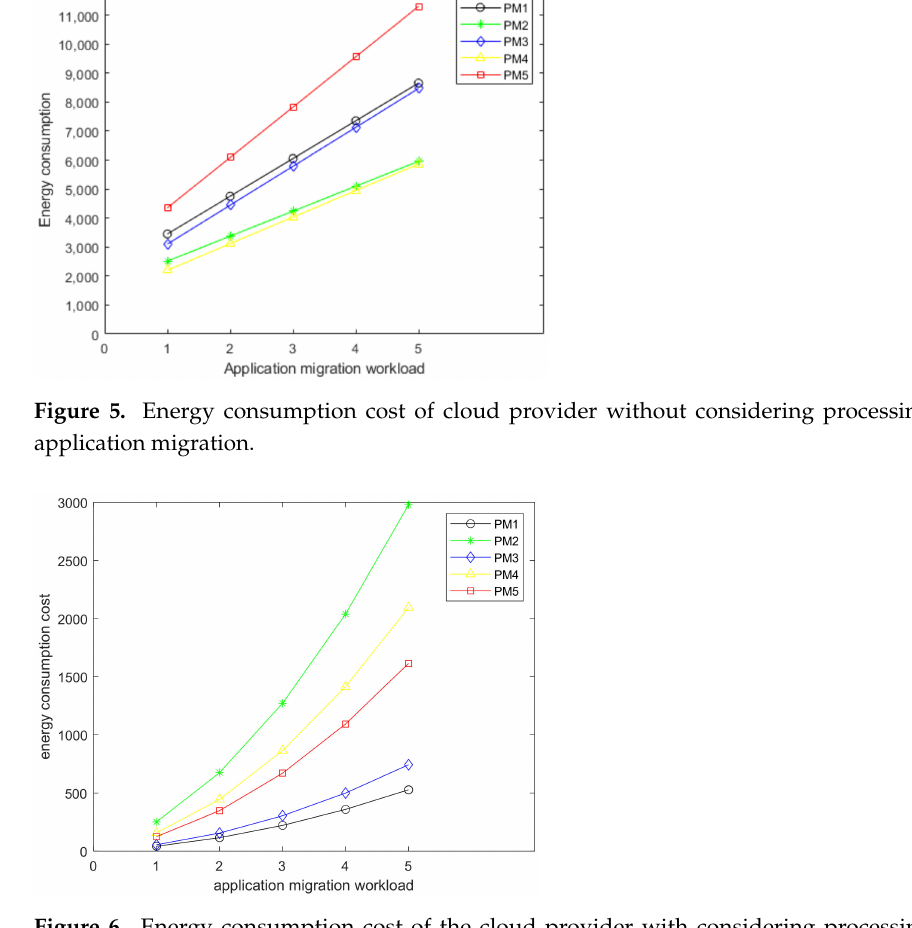
Figure 6. Energy consumption cost of the cloud provider with considering processing time of application